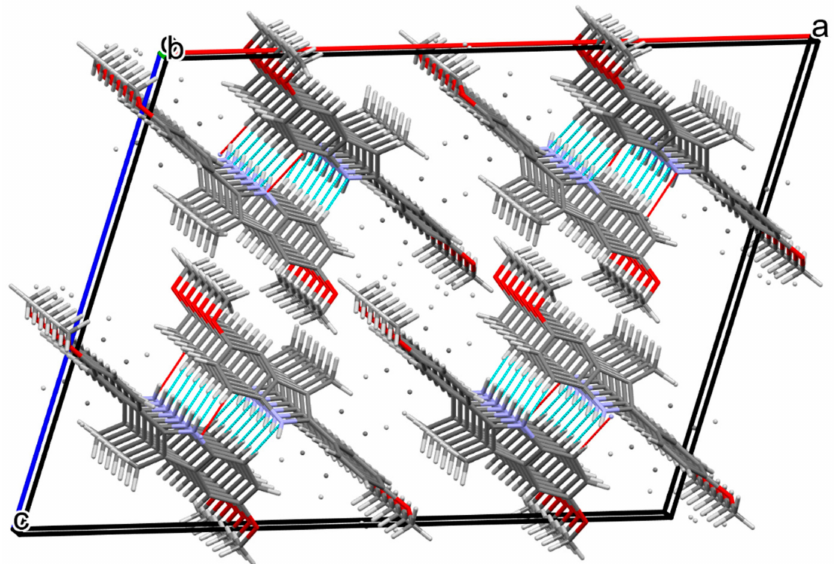
Figure 2. Crystal packing for compound 1 showing hydrogen bonds as dashed blue lines.